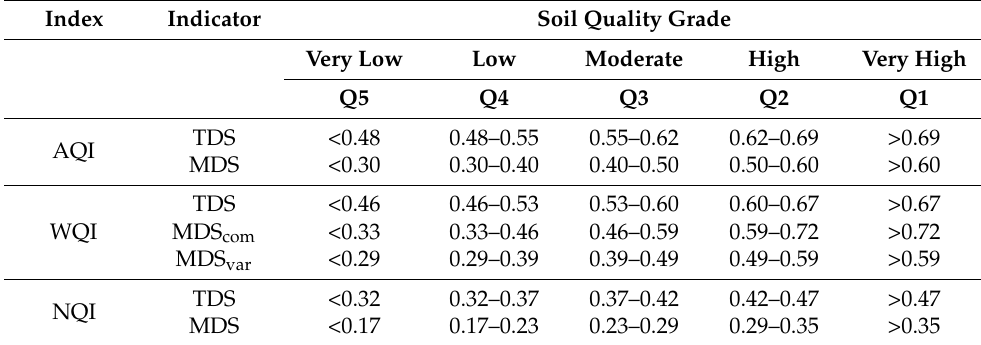
Table 5. Soil quality grades classification criteria for indices within indicator methods.